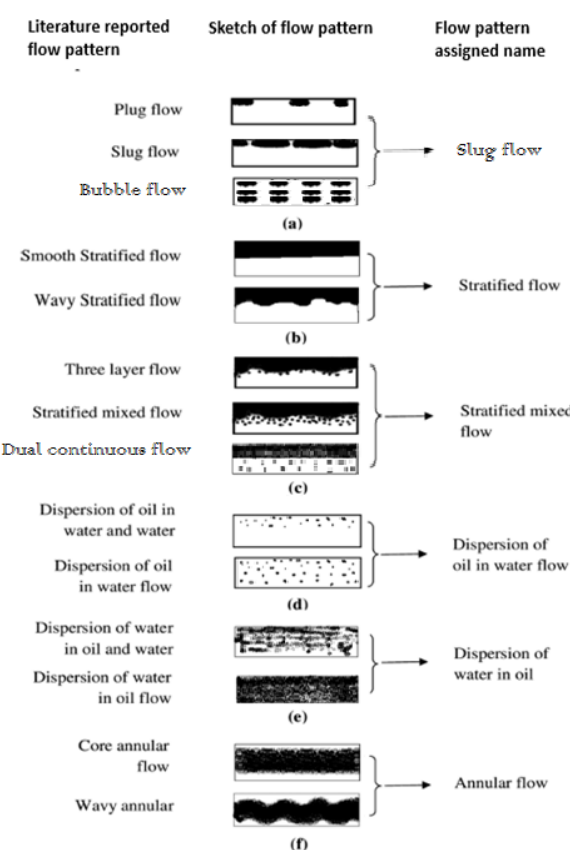
Figure 5. Grouping of the flow patterns modified after Dasari et al. [58].